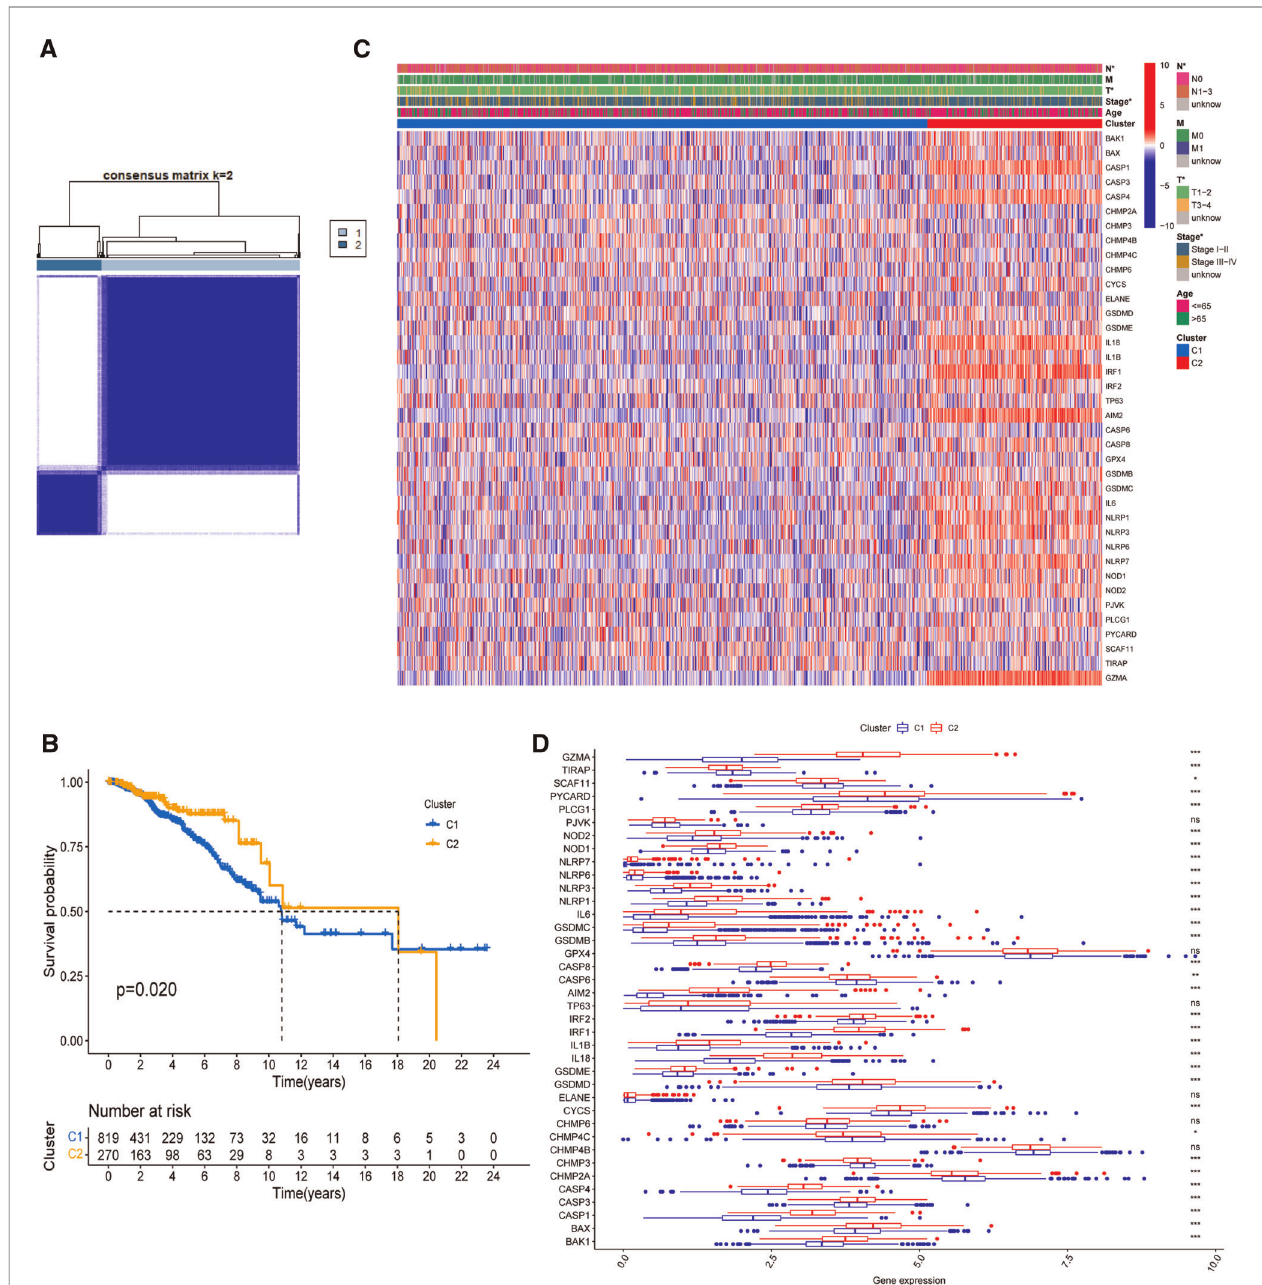
FIGURE 2 | Identi fi cation of PR clusters based on 38 PR DEGs. ( A ) Consensus clustering analysis using 38 PR DEGs. All breast cancer (BC) samples were separated into two PR clusters. ( B ) Survival analysis of BC patients for the two PR clusters. ( C ) Heatmap indicating the correlations between two clusters and clinicopathologic characters. ( D ) Expression levels of 38 PR DEGs in two PR clusters. * p <0.05, ** p <0.01, *** p <0.001, ns, not signi fi